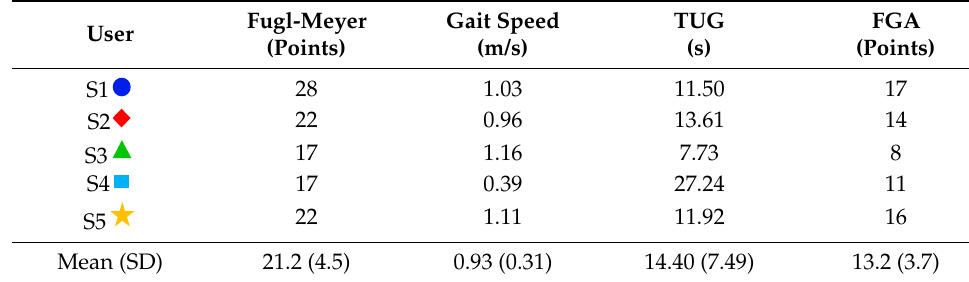
Table 1. Participants characteristics.